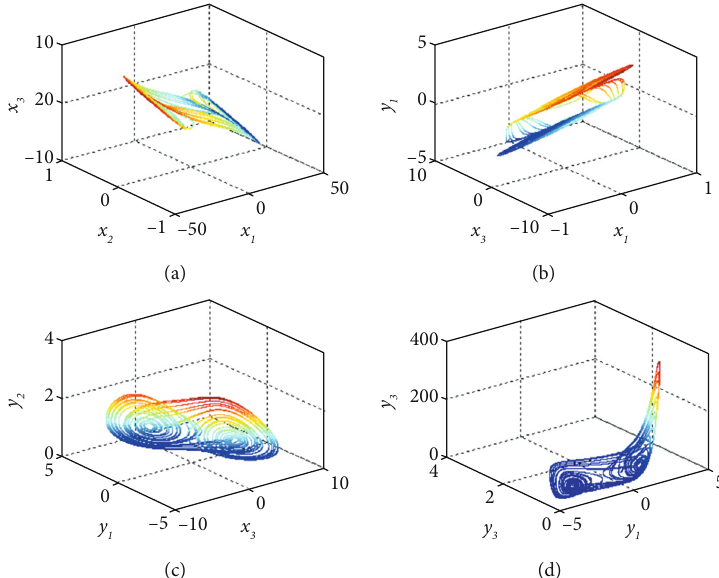
Figure 18: The chaotic trajectory of the unidirectionally coupled Chua ’ s circuit with the exponential manifold y = ½ x space: (a) x